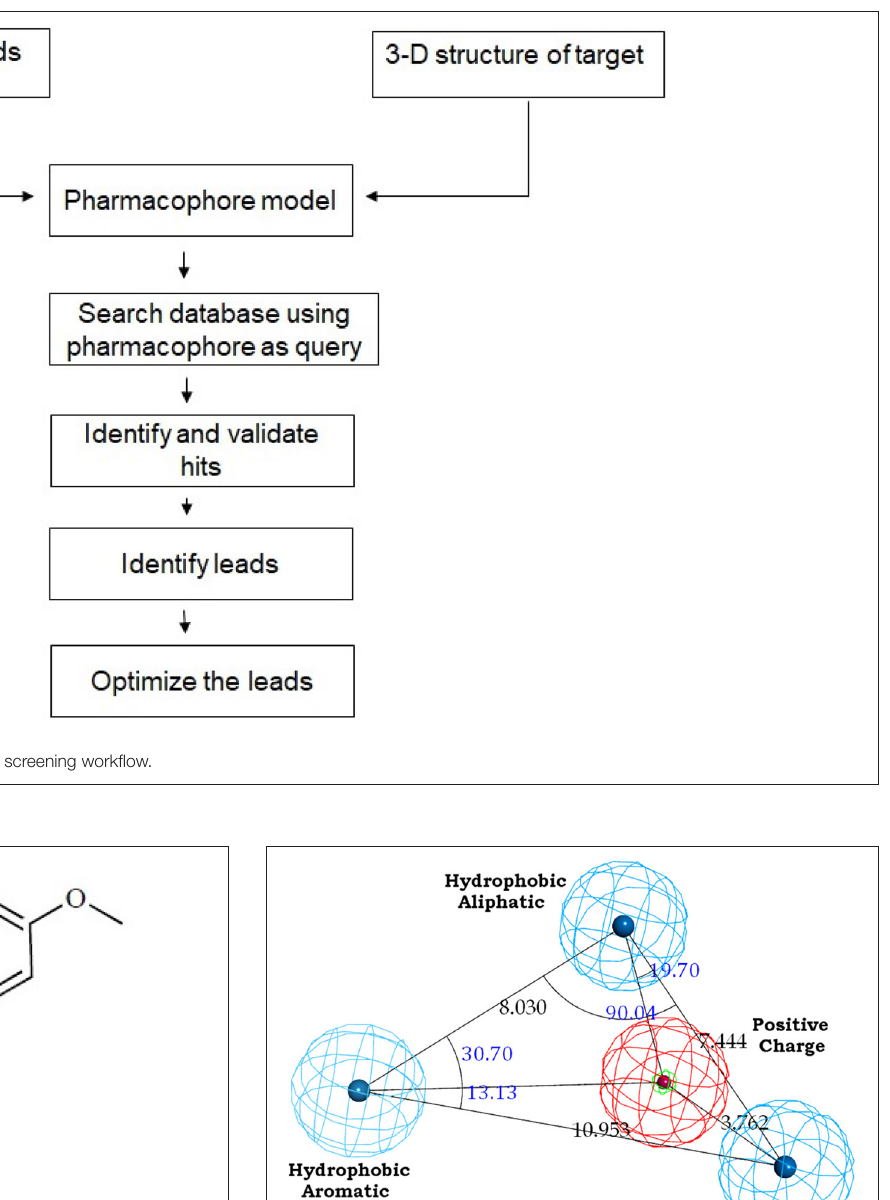
FIGURE 7 | The chemical structure of the non-protonated ligand showing activity toward κ -opioid receptor. Reproduced with permission from Bentham Science Publishers [247].